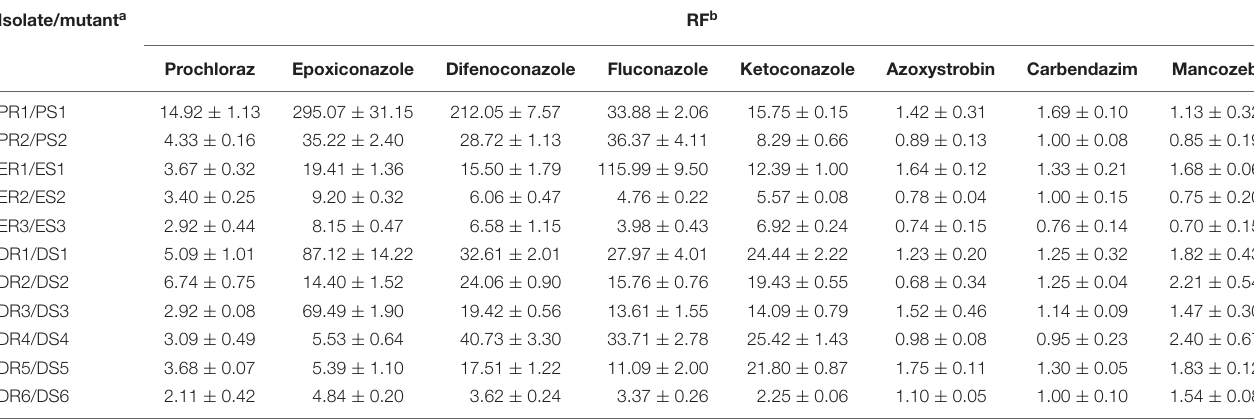
TABLE 4 | Cross-resistance among three agricultural DMIs (prochloraz, epoxiconazole, and difenoconazole), two clinical DMIs (fluconazole and ketoconazole), and three non-DMIs (azoxystrobin, carbendazim, and mancozeb). Isolate/mutant